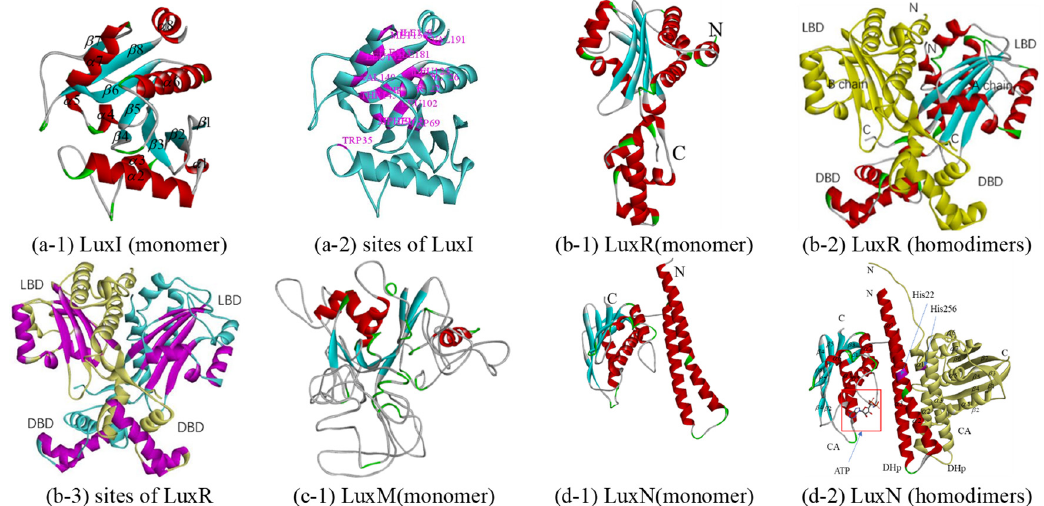
Figure 2. Predicted structure–function diagram of autoinducer synthases and receptor (LuxI/LuxR and LuxM(AinS)/LuxN(AinR)), where the colorful ribbon diagram refers to chain A, yellow to chain B, and “N” and “C” refer to N-terminal and C-terminal of the protein. ( a-1 ), ( b-1 ), ( c-1 ), and ( d-1 ) are the ribbon diagrams of monomers; ( b-2 ) and ( d-2 ) are the ribbon diagram of oligomers, where the red box refers to predicted binding-site and purple refers to the residues of the site; ( a-2 ) and ( b-3 ) are the active site or binding pocket site diagram of target proteins.